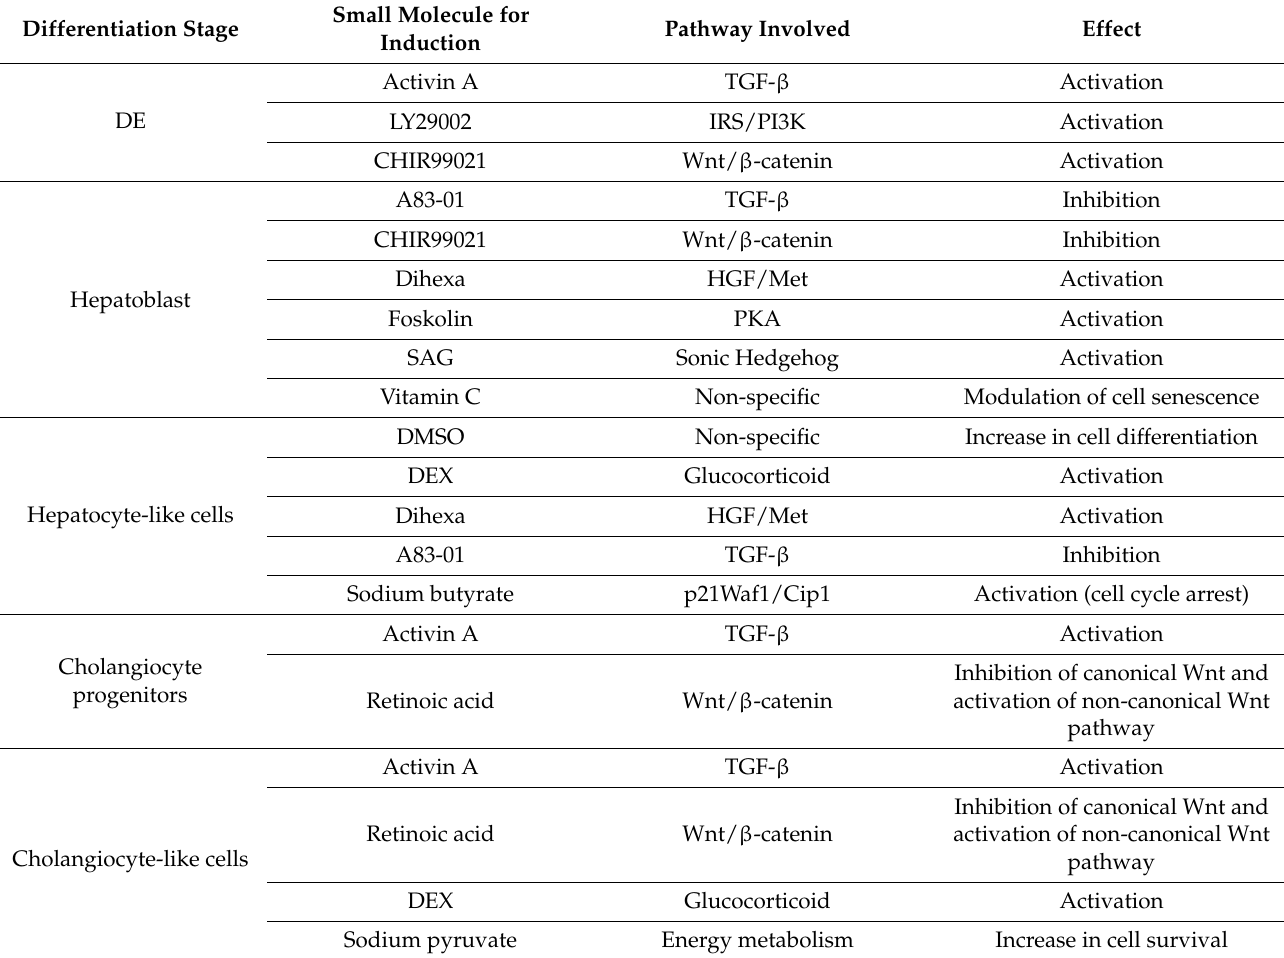
Table 1. List of small molecules used for hepatobiliary cell fate